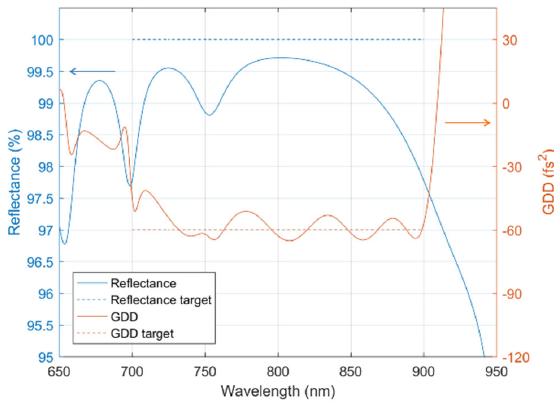
Figure 7. Layer thicknesses in the DCM in the final design.